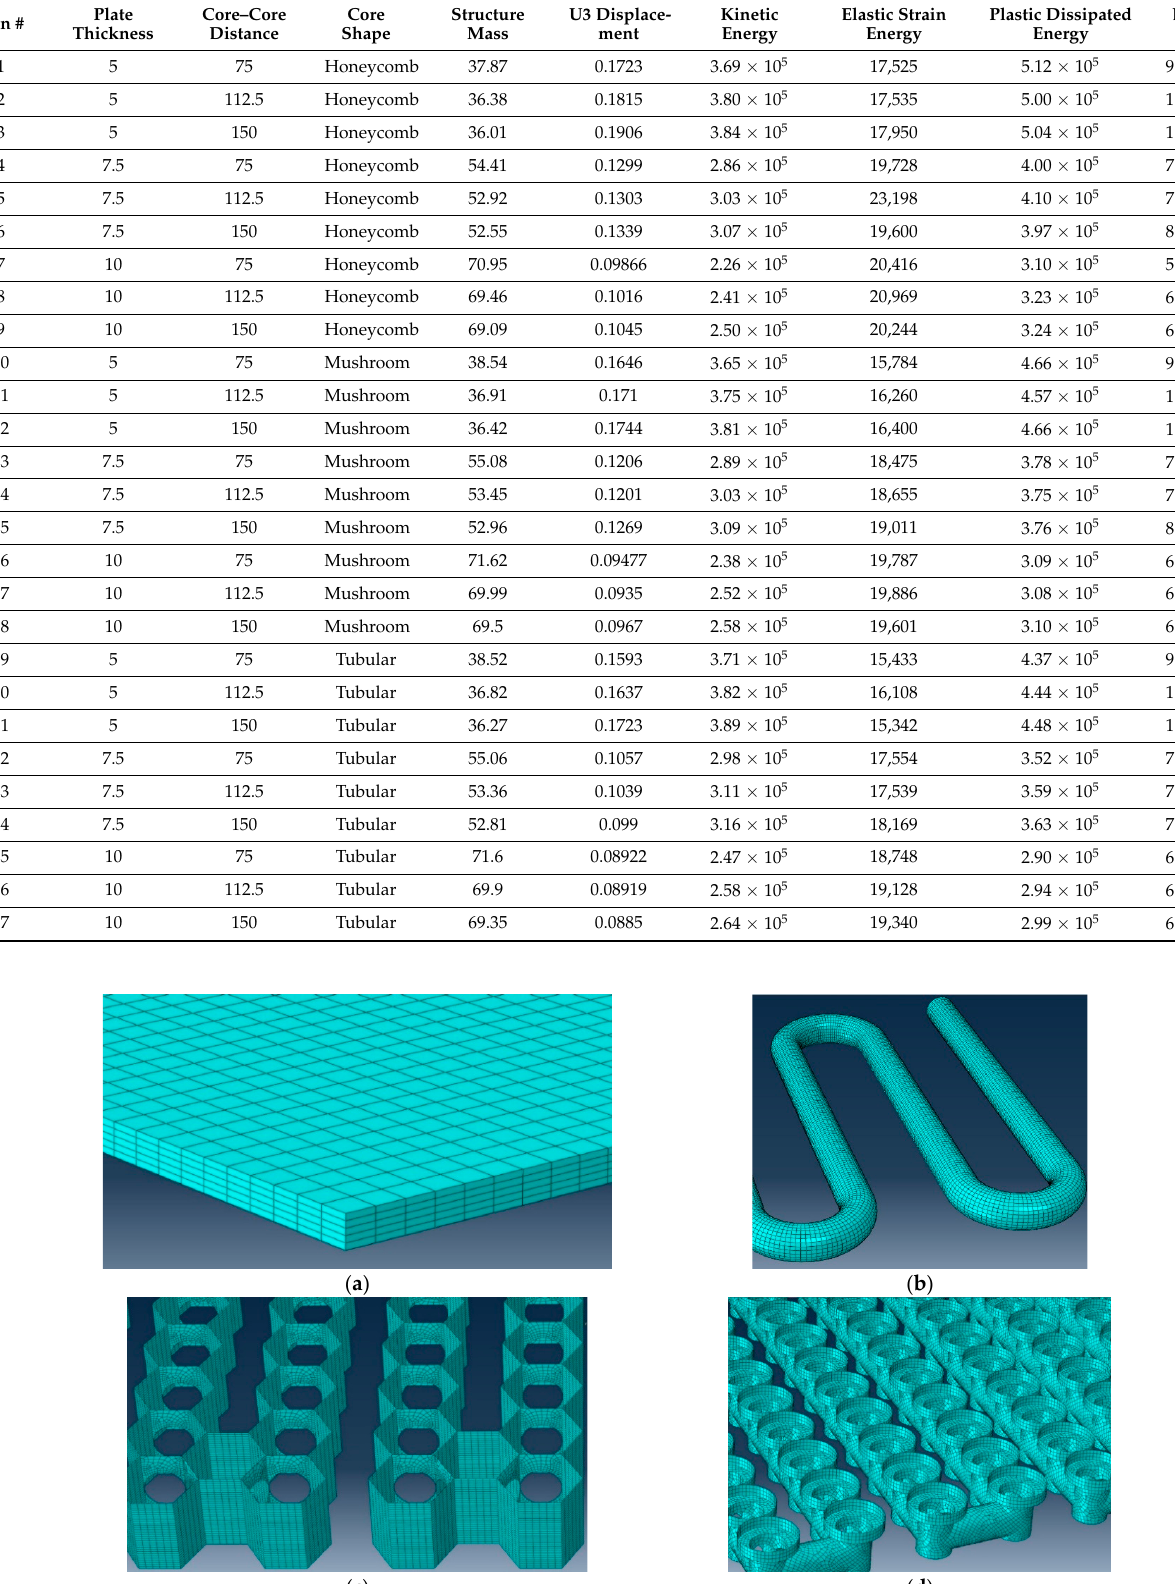
at the selected number of elements with an error of less than 2.5% upon increasing the